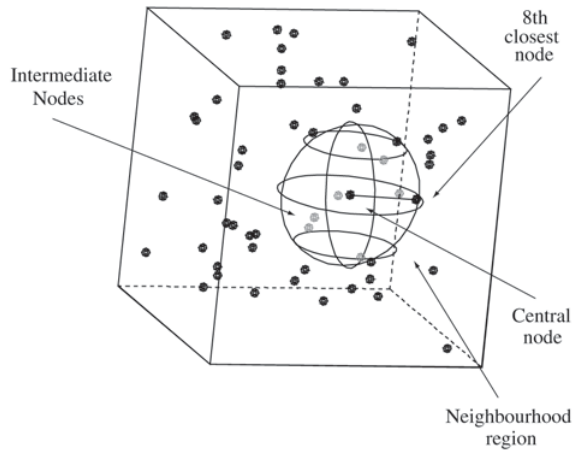
Figure 3. Neighborhood region defined by the sphere with center in the coordinates of the central node and radius equal to the dis- tance between the central node and the eighth closest